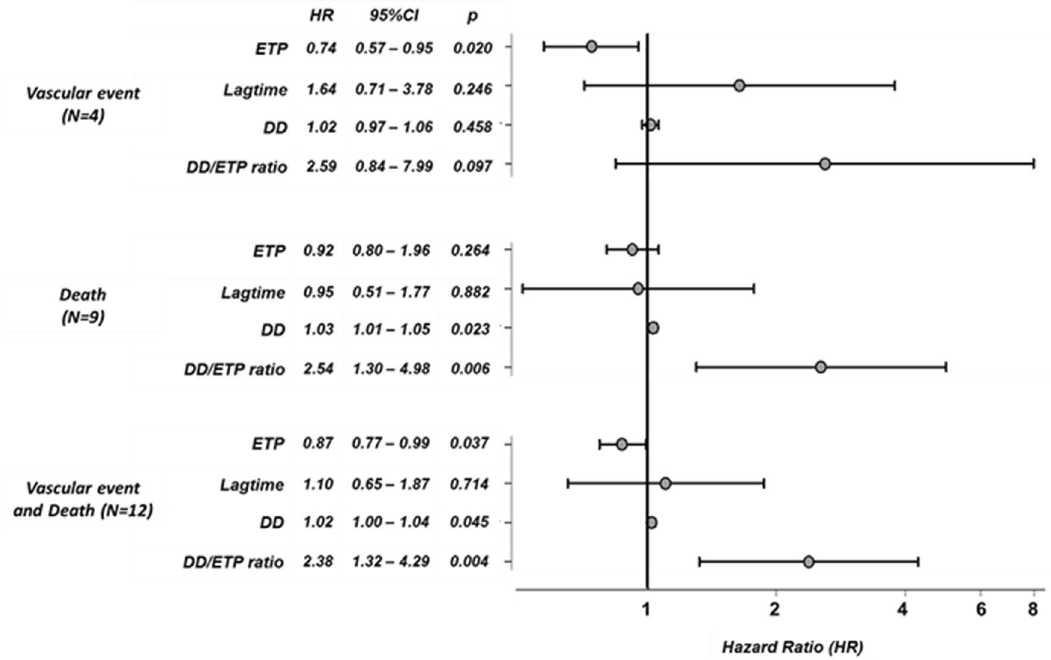
Figure 2. Cox regression analysis of baseline thrombin generation parameters, baseline D-dimer and the baseline D-dimer/ETP ratio in COVID-19 patients. Square root transformation of ETP and D-dimer and logarithmic transformation of D-dimer/ETP ratio were performed for predictive analysis. 95% confidence interval and p value are shown for each Hazard Ratio. DD: D-dimer. HR Hazard ratio.